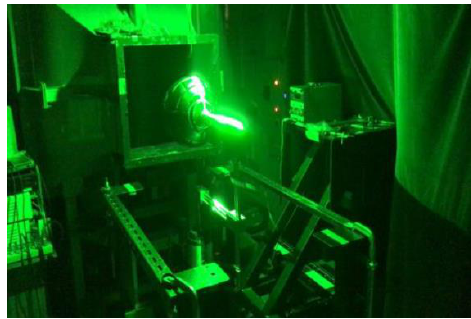
Figure 6. 2D-PIV (particle image velocimetry) measurement.